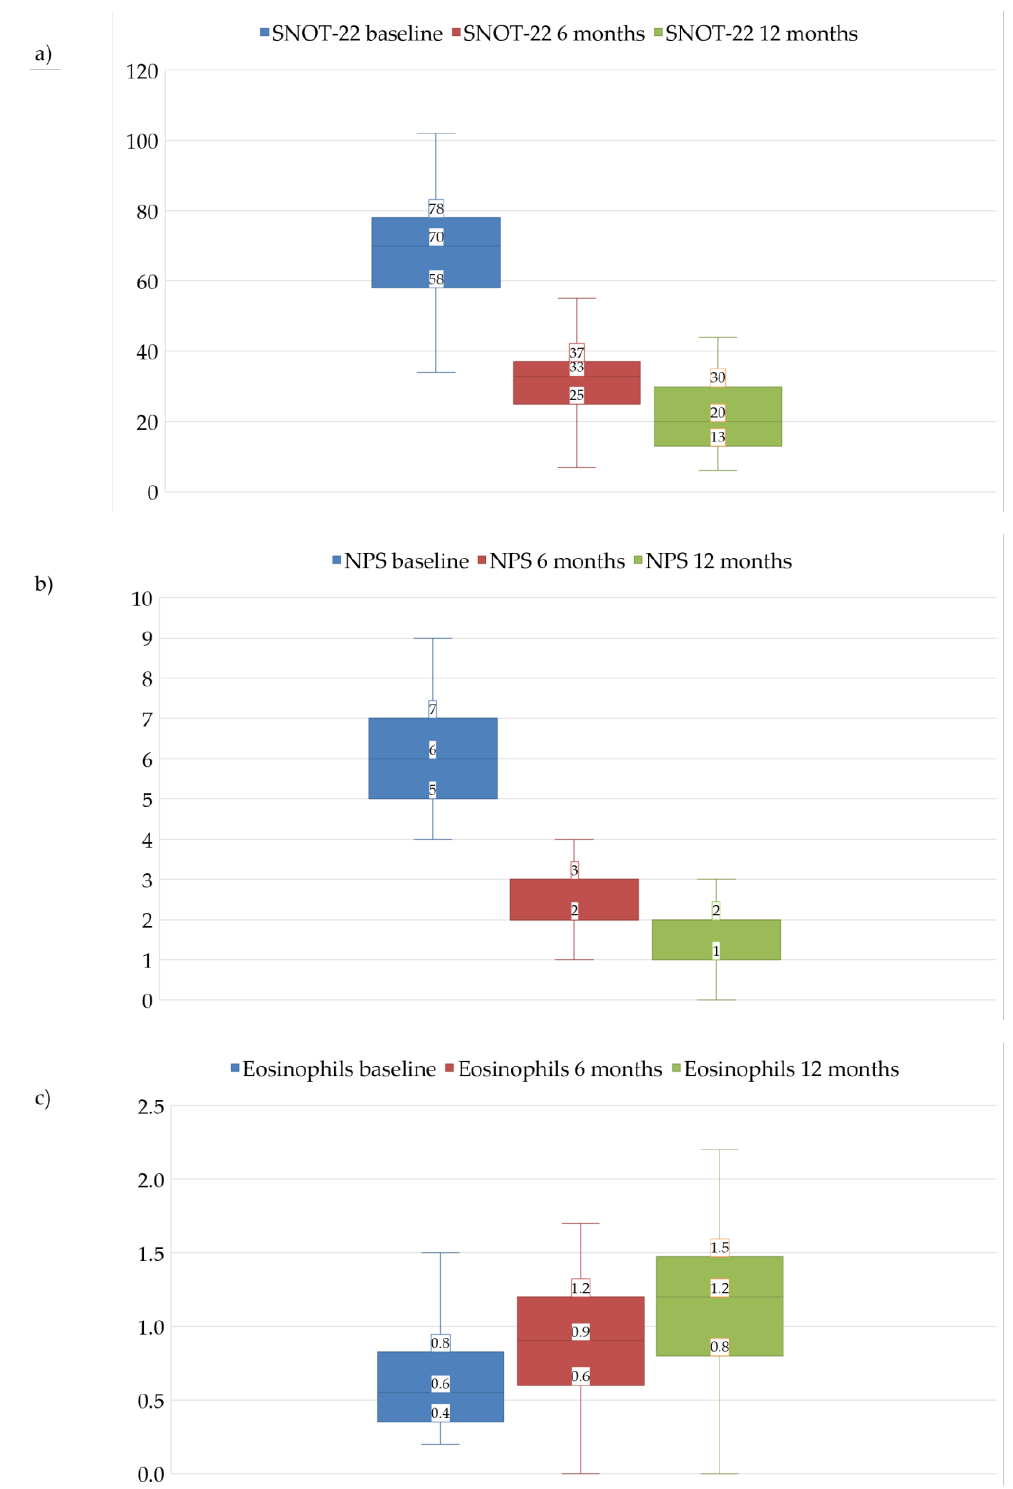
Figure 1. Median value variations over time: ( a ) SNOT-22, ( b ) NPS, ( c ) eosinophil count. SNOT-22 = Sino-Nasal Outcome Test 22; NPS = nasal polyps score.